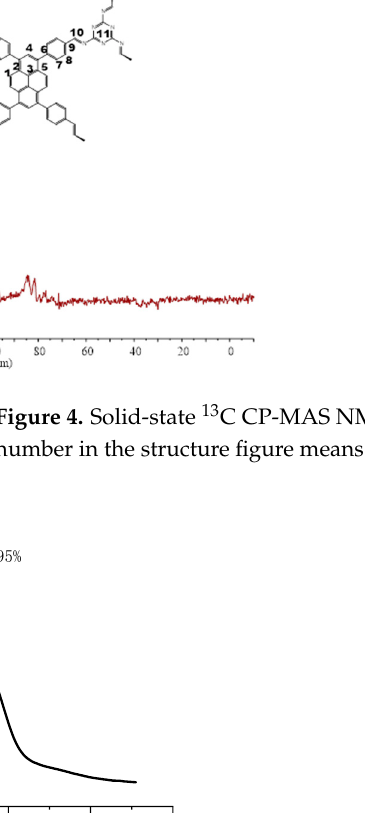
Figure 3. FT-IR spectra of ( a ) TFFPy, ( b ) melamine, ( c ) TTTA, ( d ) CMP − shu − 1 and ( e ) CMP − shu − 2.